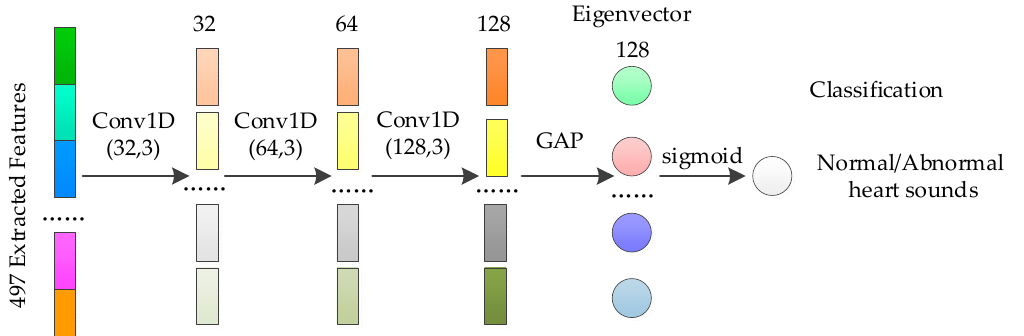
Figure 2. Structure of the designed convolutional neural network (CNN) model for normal and abnormal PCG classification. Conv1D denotes a one-dimensional convolution layer. GAP denotes the global average pooling layer.